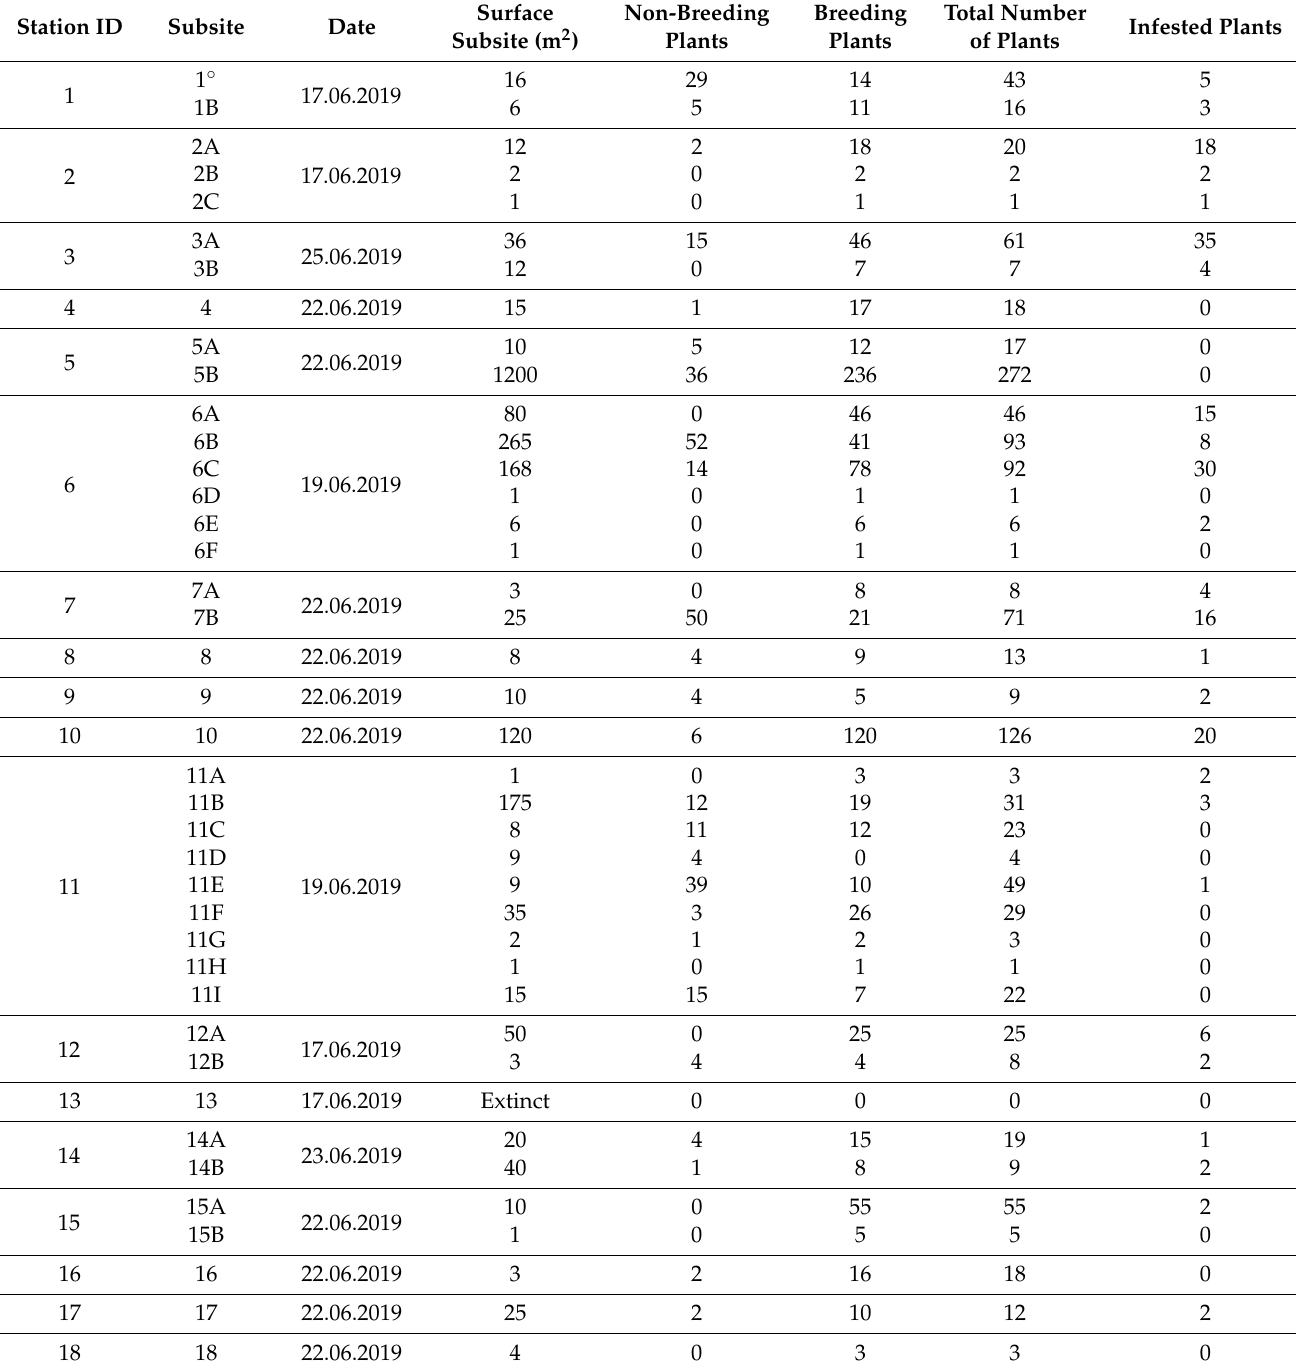
Table 1. Sampled sites with the presence of S. ceratophylloides . For all of the sites, the number of plants with different characteristics were